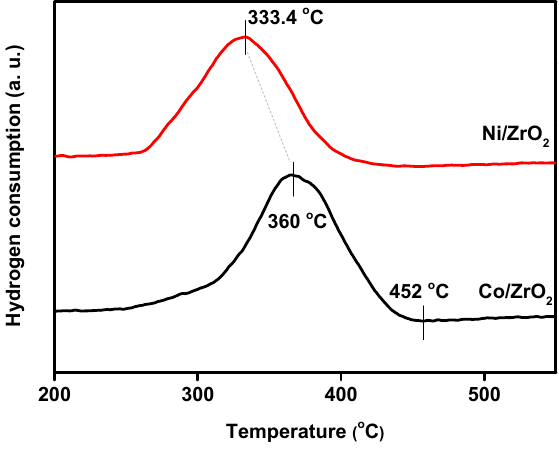
Figure 3. TPR-H 2 profiles for the Ni/ZrO 2 and Co/ZrO 2 catalysts.